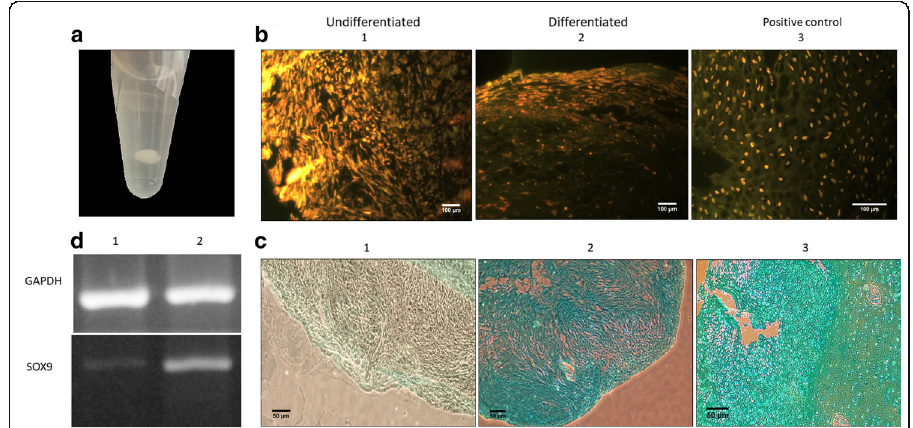
Fig. 2 Characterization of differentiated MSCs pellets in chondrogenic differentiation medium supplemented with 5% PL. a Three-dimensional round tissue pellet after 3 weeks of culture in differentiation medium. b Acridine orange staining and the distribution of the cells in the pellets i) Sections of undifferentiated pellets (negative control), image at 150× magnification. ii) Sections of differentiated pellets, image at 150× magnification. iii) Sections of chicken articular cartilage (positive control), image at 600× magnification. c Alician blue staining. i) Sections of undifferentiated pellets (negative control), image at 150× magnification. ii) Sections of differentiated pellets, image at 150× magnification. iii) Sections of chicken articular cartilage, image at 300× magnification. d 2% agarose gel electrophoresis for amplified transcripts of SOX9 and GAPDH . i) Amplified transcripts in undifferentiated pellets. ii) Amplified transcripts in differentiated pellets. The data are representative from one out of three donors tested ( n